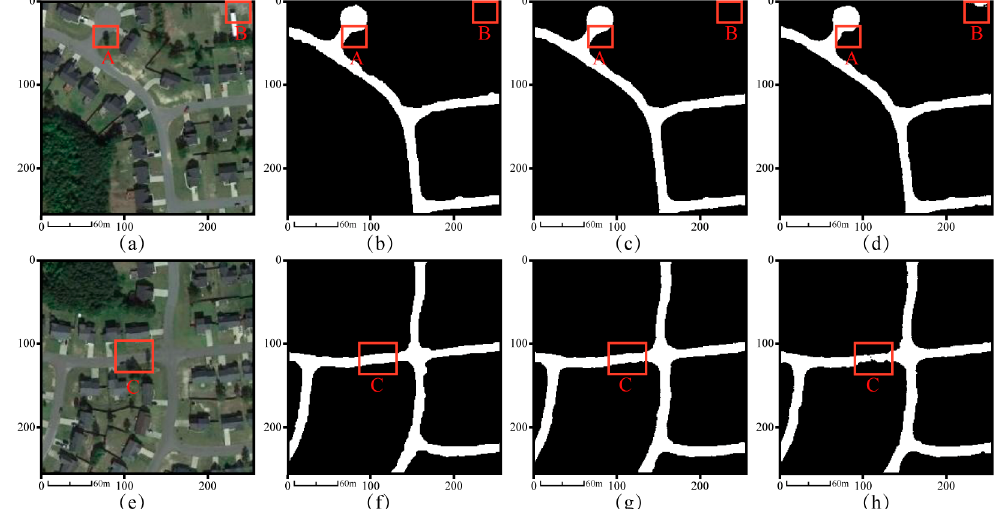
Figure 10. Results of road extraction from the remote sensing imagery with and without LAU. ( a , e ) The original remote sensing image. ( b , f ) The corresponding ground truth image of this region. ( c , g ) The prediction results using the GL-Dense-U-Net model. ( d , h ) The prediction results without LAU.